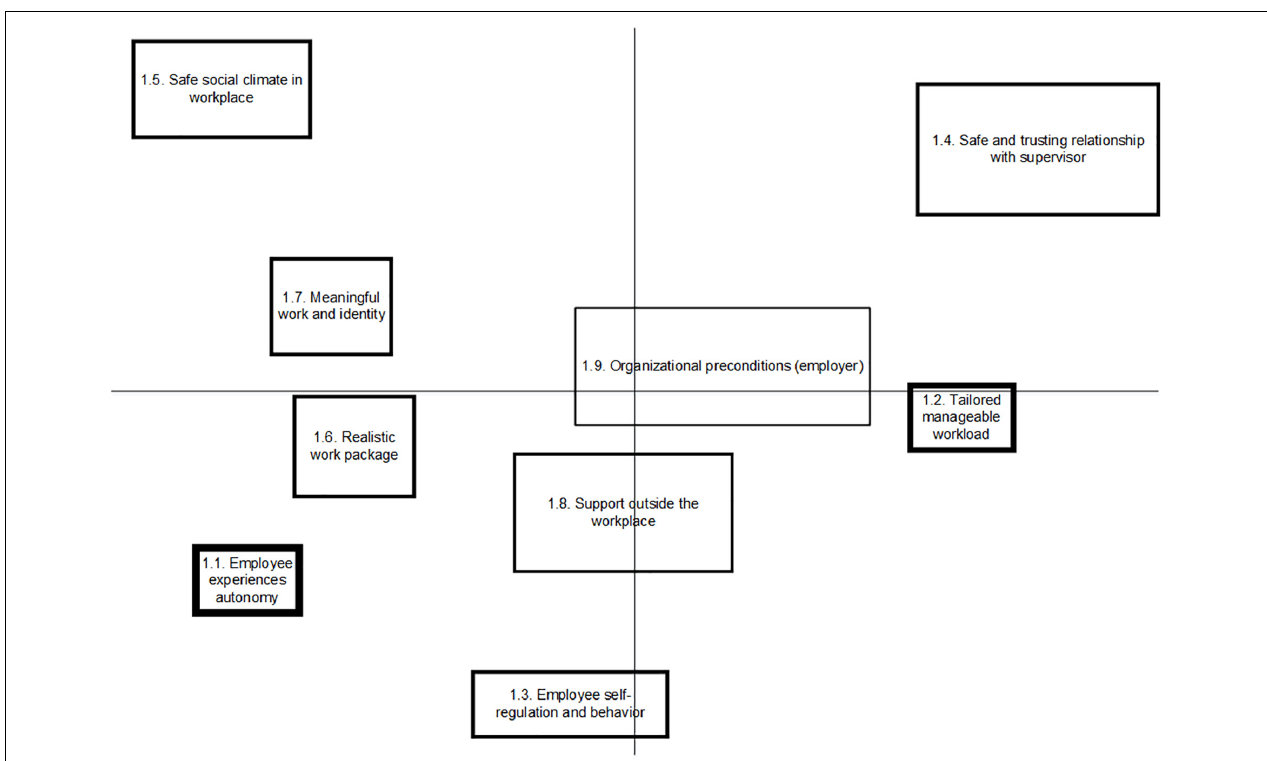
FIGURE 1 | Concept map on factors promoting Stay at work, representing the perspective of employees with